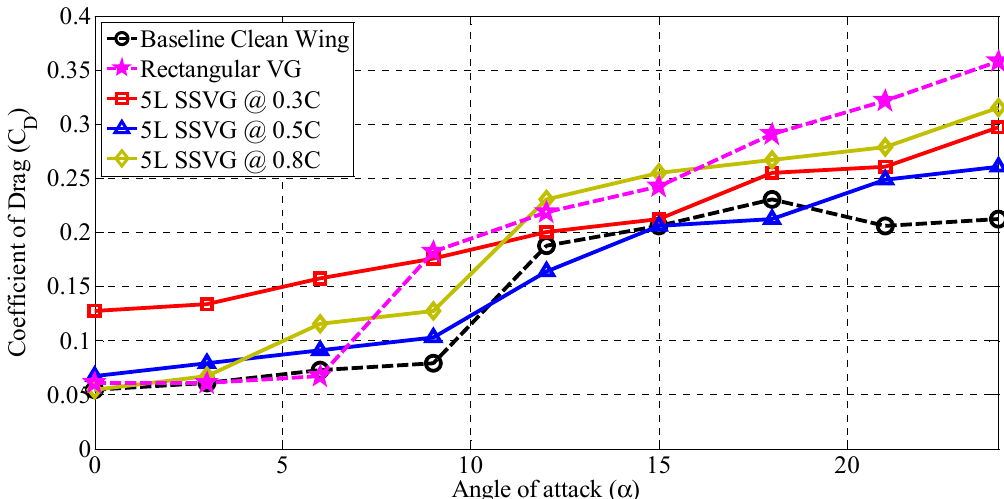
Figure 16. Coefficient of drag ( C D ) vs. angle of attack ( α ) for baseline and modified model with large-sized (5L) SSVG.